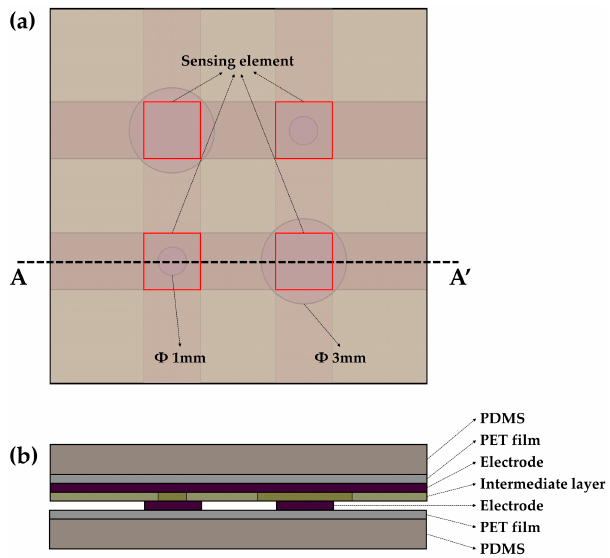
Figure 1. The structure of the sensor; ( a ) Top view; ( b ) Cross-sectional view along the AA’ line.